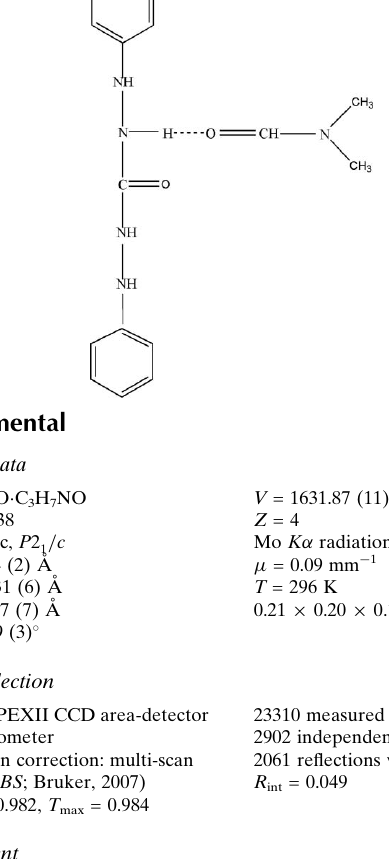
Data collection Bruker APEXII CCD area-detector diffractometer Absorption correction: multi-scan ( SADABS ; Bruker, 2007) T min = 0.982, T max = 0.984